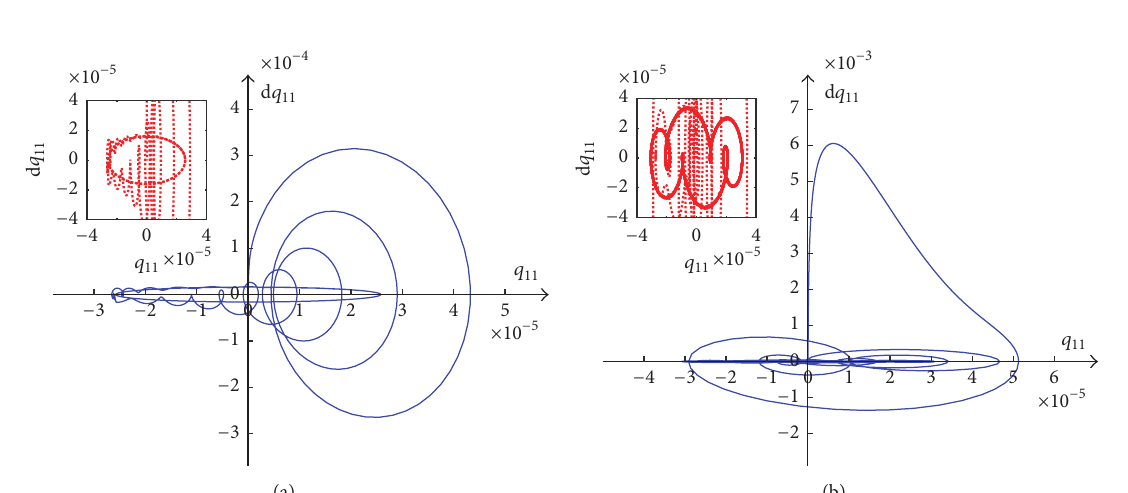
Figure 8: Longitudinal vibration.